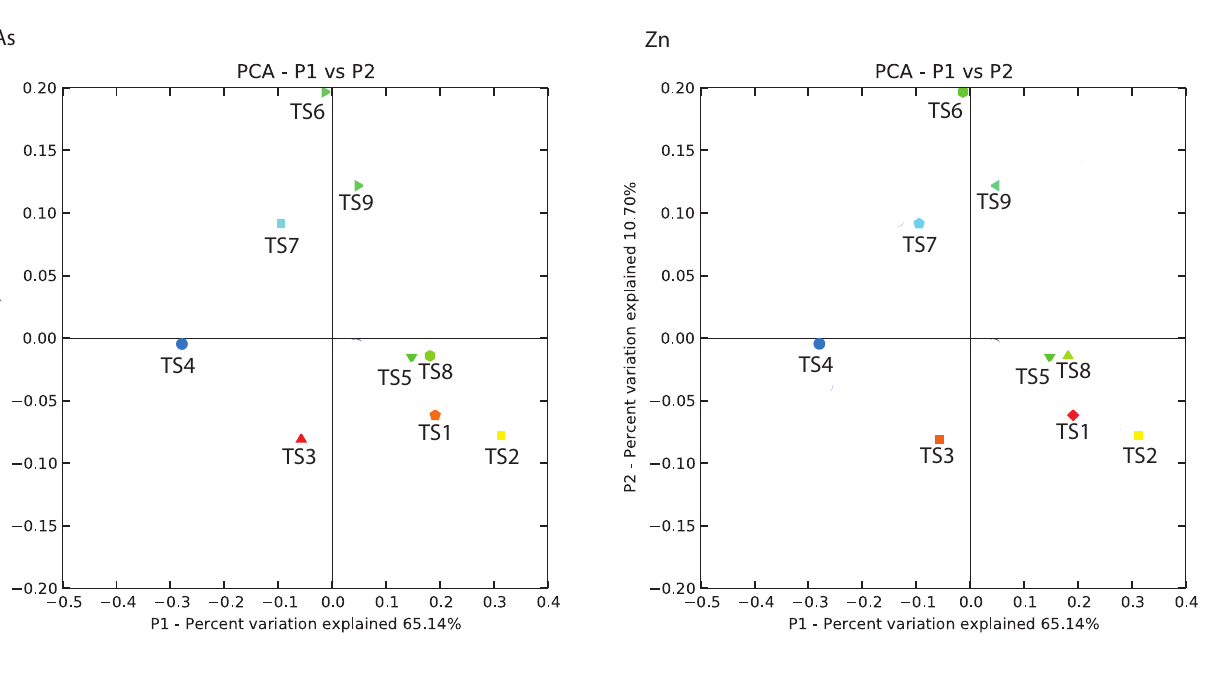
Microbial community principal coordinate analysis with arsenic and zinc concentrations coloured from blue (high) to red